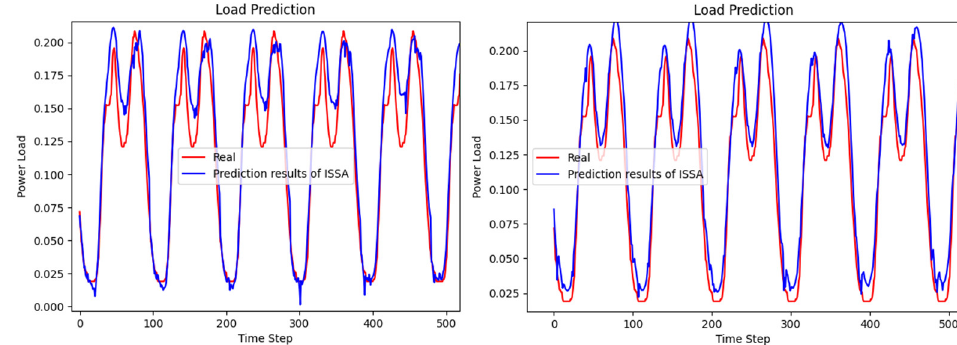
Figure 11. Prediction results of Informer-based model in 500 time steps.